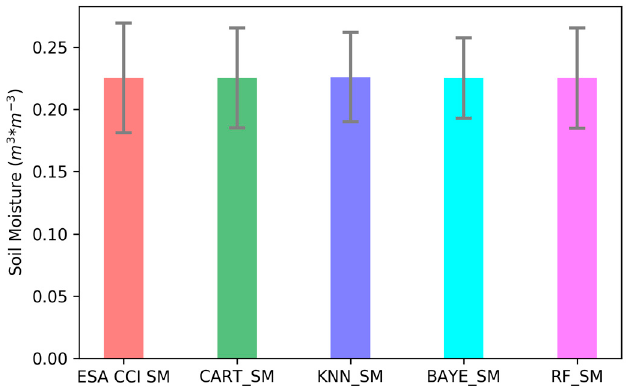
Figure 5. Comparison of ESA CCI SM, CART_SM, KNN_SM, BAYE_SM and RF_SM by error bars. Table 2. Monthly slope, interception, RMSE, MAE and R 2 between ESA CCI SM and the four Similarly, we analyzed the matching level between ESA CCI SM and the four algorithms regressed data.